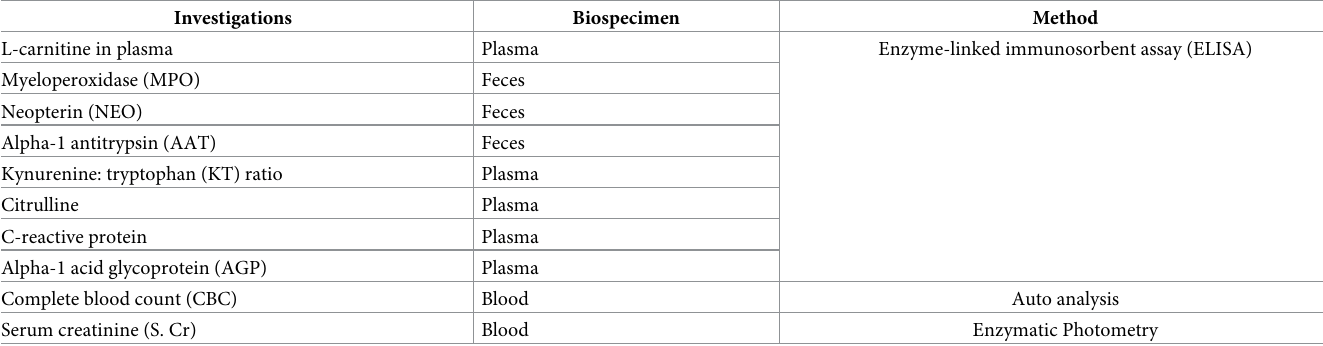
Table 2. Laboratory investigations to be performed in the